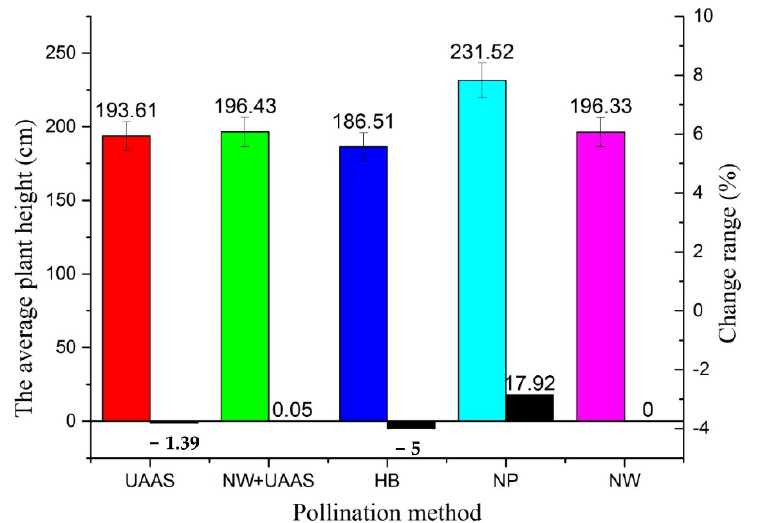
Figure 5. The APHs of different pollination areas and APH change ranges. Note: UAAS—unmanned agricultural aerial system; NW+UAAS—natural wind + UAAS; HB—honeybee; NP—no pollinators; NW—natural wind; APH—average plant height.